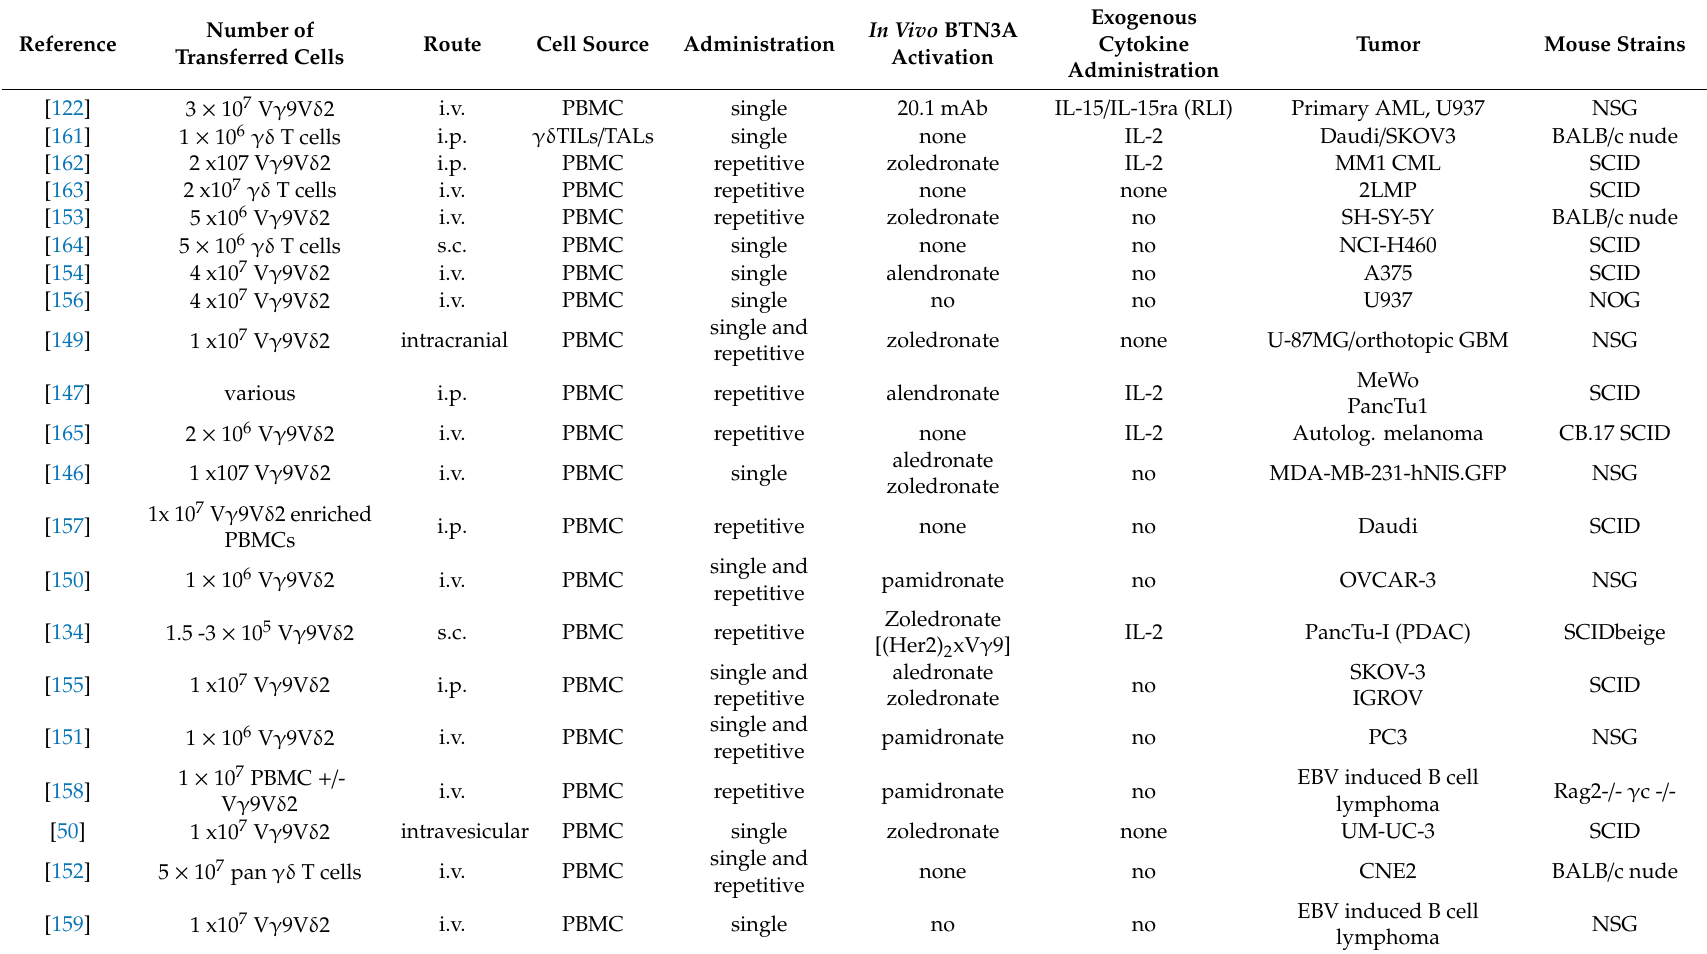
Table 3. Summary of dual xenograft in vivo mouse studies involving V γ 9V δ 2 T cells. (i.v.) intravenous; (i.p.) intraperitoneal; (s.c.) subcutaneous.